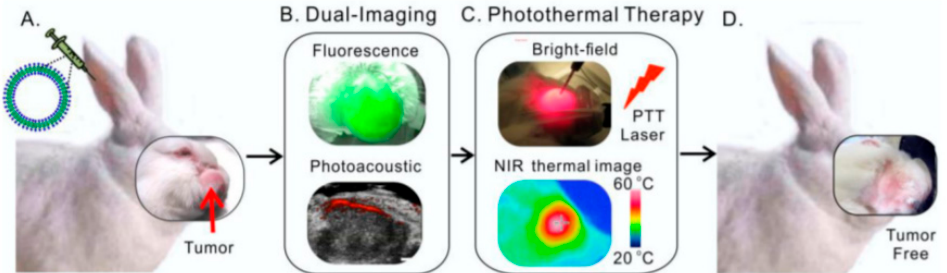
Figure 4. Schematic image of the dual-imaging and PTT effect on head and neck cancer from rabbit. ( A ) Porphysomes injected intravenously via ear vein of the rabbit; ( B ) at 24 h post-injection, both fluorescence and photoacoustic imaging were enabled; ( C ) in vivo photothermal ablation of rabbit tumor by two-step ablations (intra-tumor and transdermal); ( D ) the tumor was eliminated with no recurrence. Adapted with permission from Muhanna, Jin, Huynh, Chan, Qiu, Jiang, Cui, Burgess, Akens, Chen, and Irish. Phototheranostic porphyrin nanoparticles enable visualization and targeted treatment of head and neck cancer in clinically relevant models. Theranostics. 2015;5(12):1428;